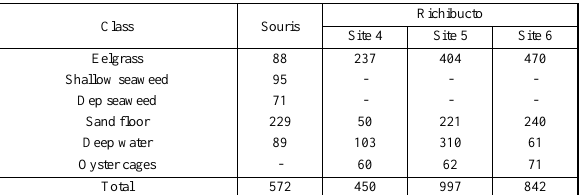
Number of training polygons per class for the UAV image